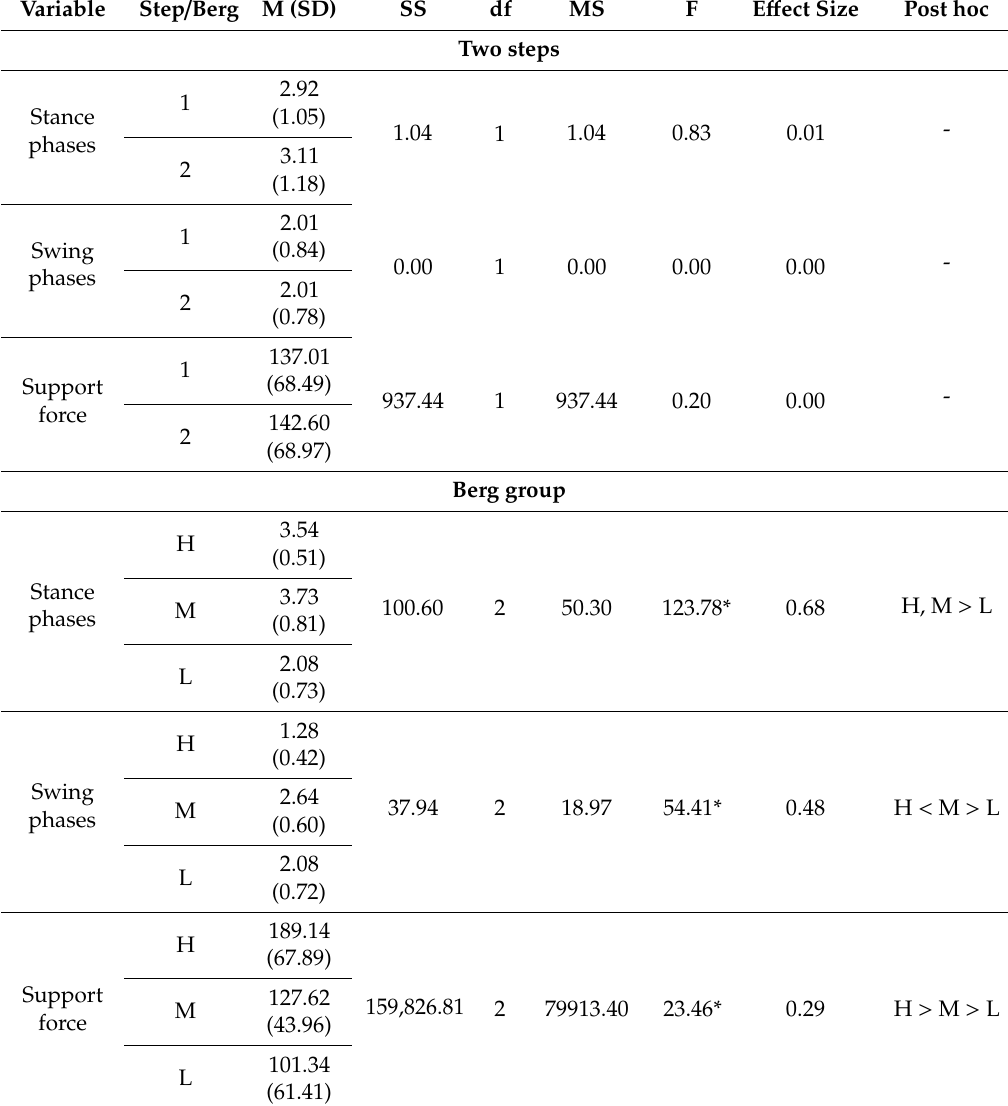
Table 1. Analysis of variance (ANOVA) table for two steps and Berg group in stance, swing phases, and support force while using a